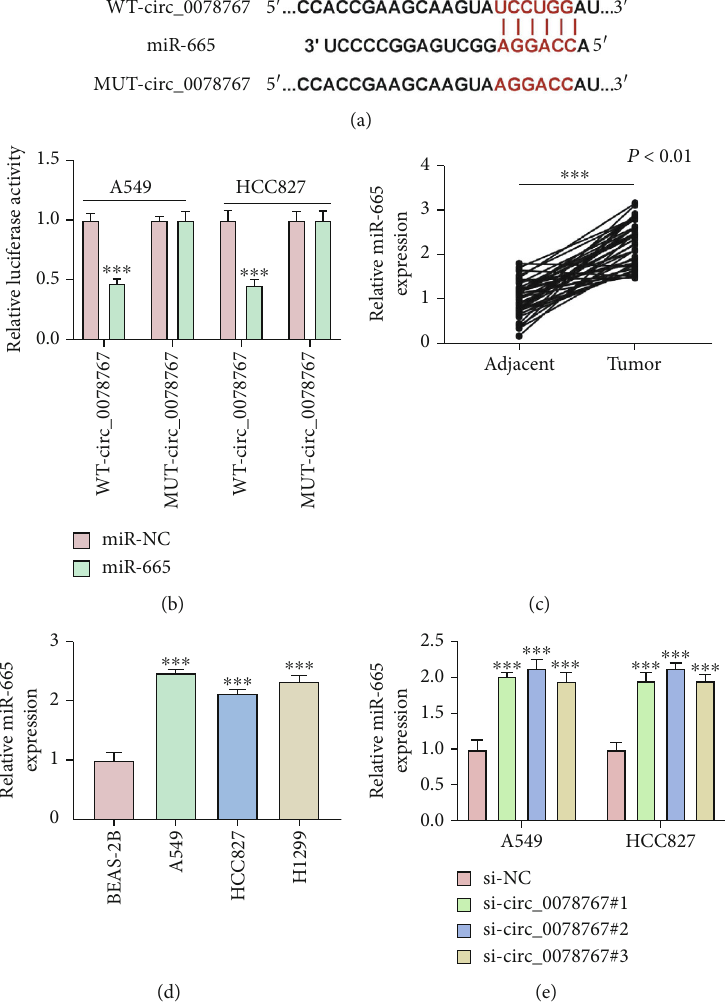
Figure 3: Circ_0078767 functions as a sponge of miR-665. (a) The complementary sequences between miR-665 and circ_0078767 were shown. (b) Dual-luciferase reporter assays were performed to con fi rm the association between miR-665 and circ_0078767. (c, d) The expression of miR-665 in NSCLC tissues ( n = 40 ) and cells was tested by qRT-PCR. (e) The expression of miR-665 in NSCLC cells was tested by qRT-PCR. ∗∗∗ P < 0 : 001